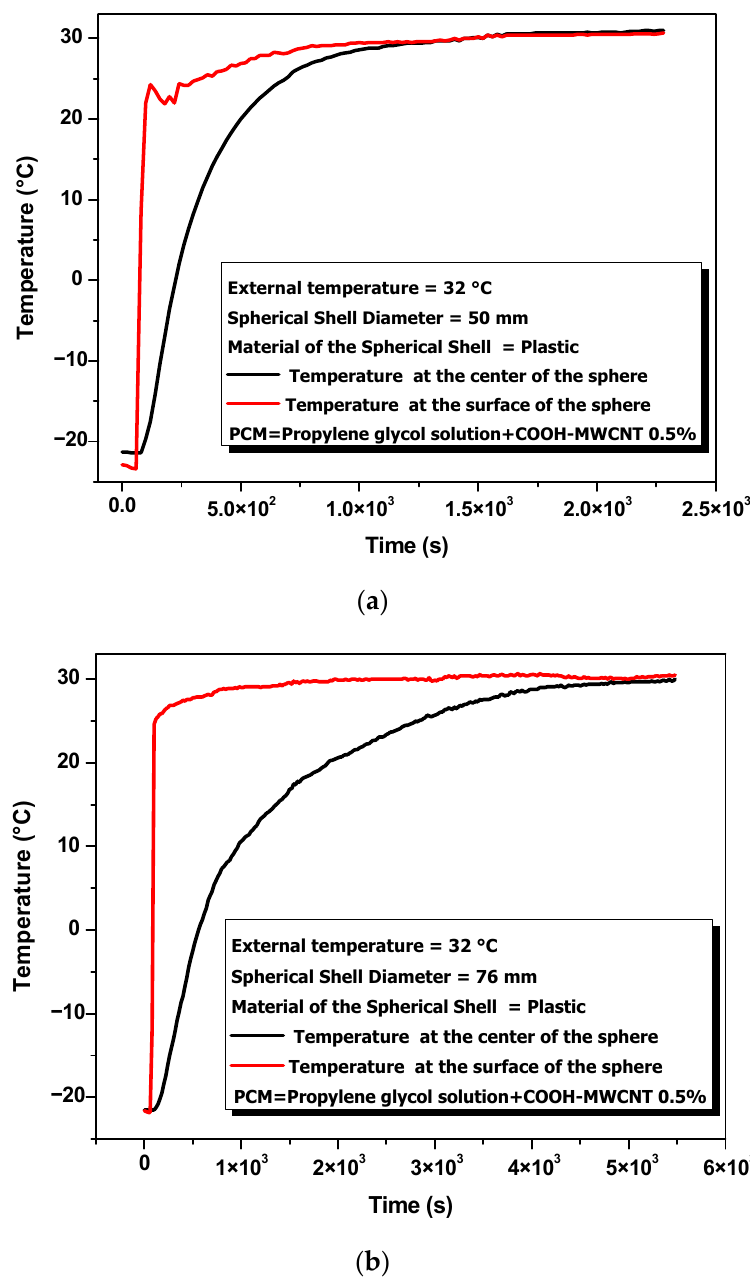
Figure 13. Temperature change in the center of the plastic spherical capsule during melting of nanofluids.